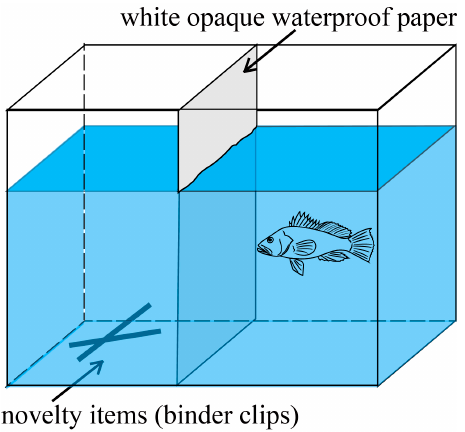
Figure 2. Device used to assess the neophobia of black rockfish ( Sebastes schlegelii Hilgendorf, 1880). The middle of the device was separated by white opaque waterproof paper. The experimental fish were placed on one side, while novelty items were placed on the other. The glass plate was removed at the beginning of the experiment.